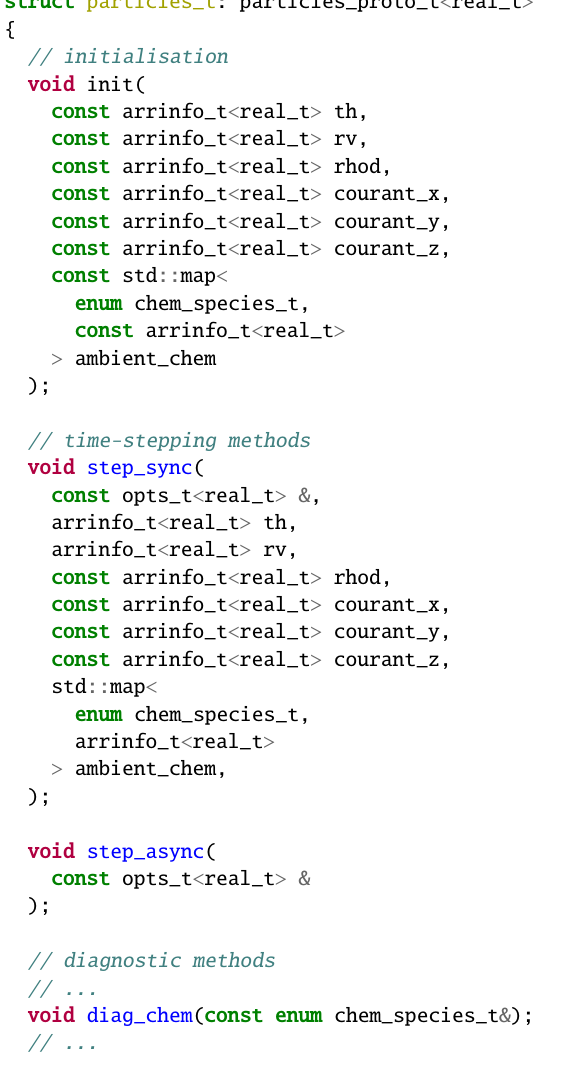
Figure A4. lgrngn::particles_t